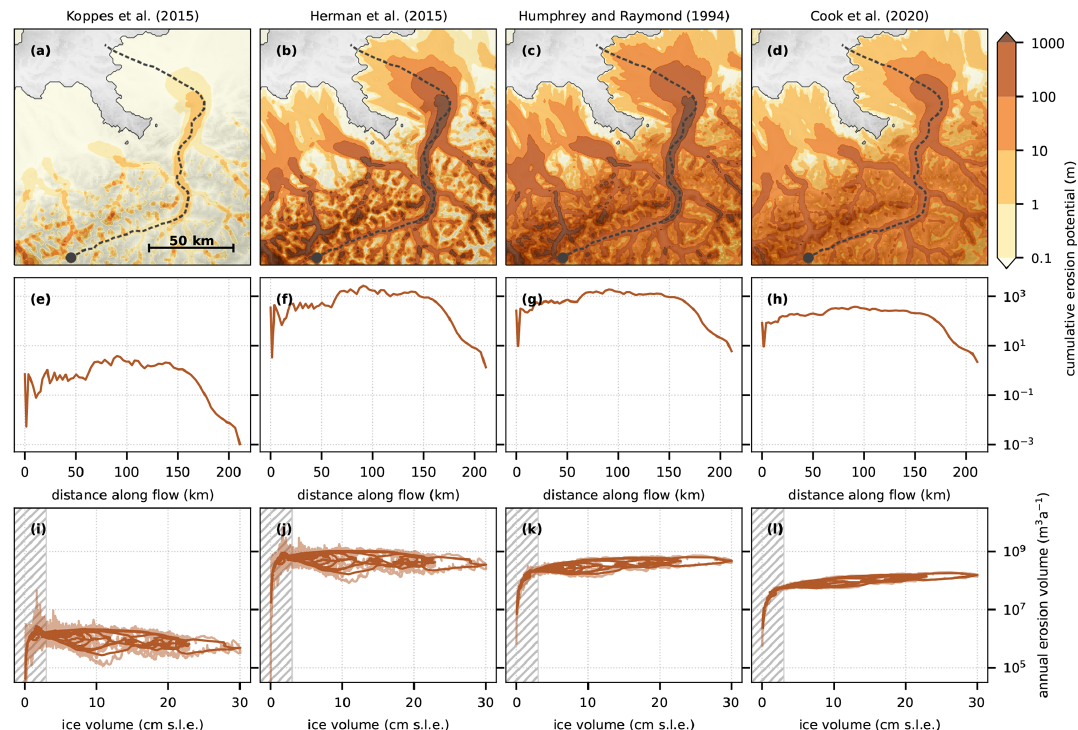
Figure 6. Modelled cumulative (time-integrated) glacial erosion potential for three different erosion laws published by (a) Koppes et al. (2015), 5 . 2 × 10 − 8 u 2 . 34 (same as Fig. 1a but with a different colour scale); (b) Herman et al. (2015), 2 . 7 × 10 − 7 u 2 . 02 ; (c) Humphrey b b and Raymond (1994), 1 × 10 − 4 u 1 ; and (d) Cook et al. (2020), 1 . 665 × 10 − 1 u 0 . 6459 . (e–h) Corresponding modelled cumulative glacial b b erosion potential along a Rhine Glacier transect (upper panels, dashed line) and (i–l) corresponding modelled evolution of annual (domain- integrated) erosion volume (light brown) and 1ka running mean (dark brown) in relation to modelled total ice volume in centimetres of sea-level equivalent (as in Fig.